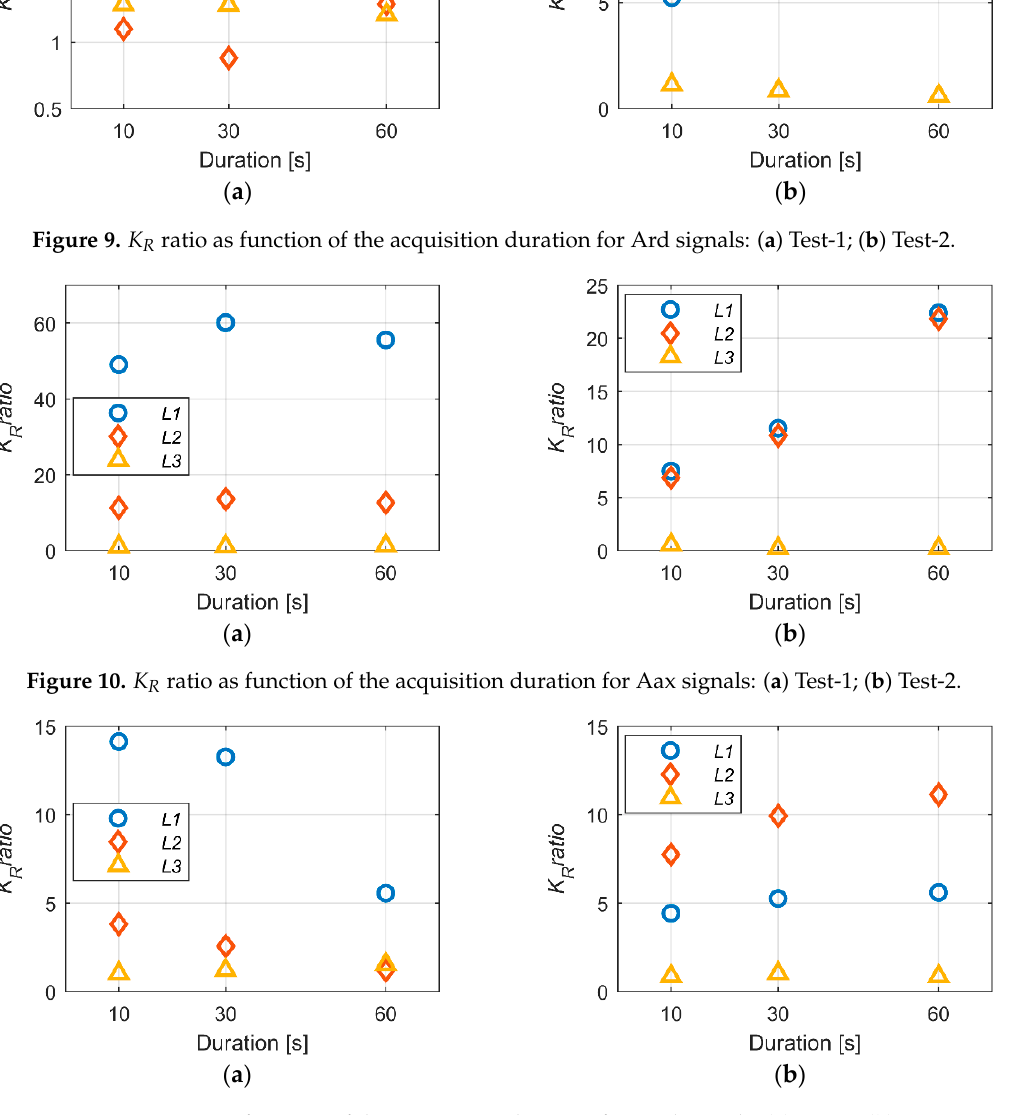
Figure 11. K R ratio as function of the acquisition duration for Hyd signals: ( a ) Test-1; ( b ) Test-2.